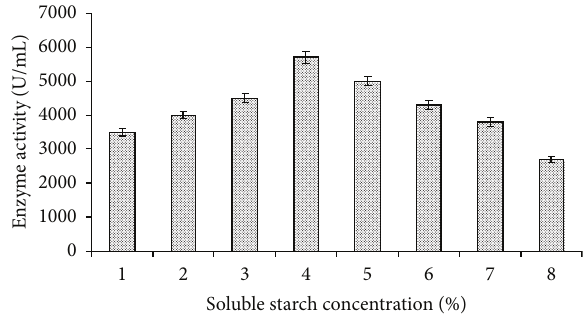
Figure 7: Effect of different concentration of soluble starch on amy- lase production. Test flasks contained different concentrations of starch (1.0–8.0, w/v) in the medium. The flasks were inoculated with culture and incubated at 55 ∘ C for 24 h at pH 7.0. Error bars presented are mean values of ± standard deviation of triplicates of three independent